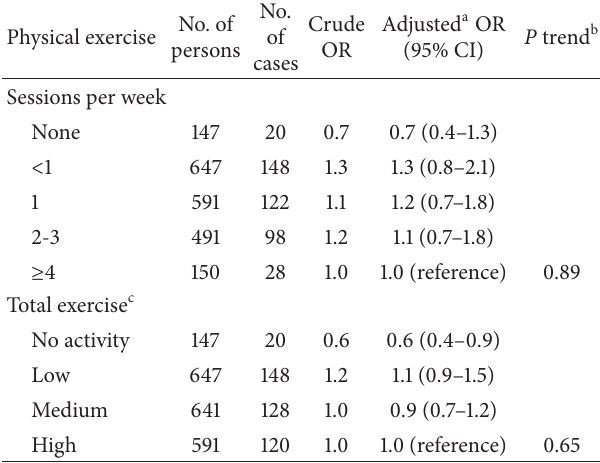
Table 3: Odds ratio (OR) from logistic regression for giving birth to a marcosomic infant (i.e., birth weight > 4000g) in association with maternal pre-pregnancy leisure time physical